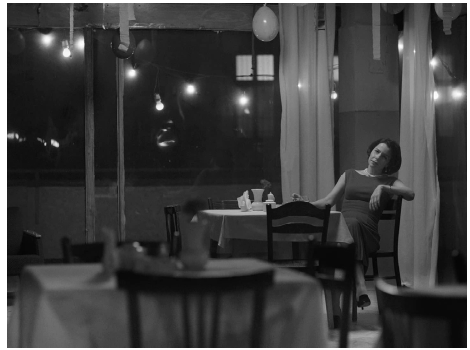
Figure 10. Wanda at a party. Figure 11. Ida in her Aunt’s dress.